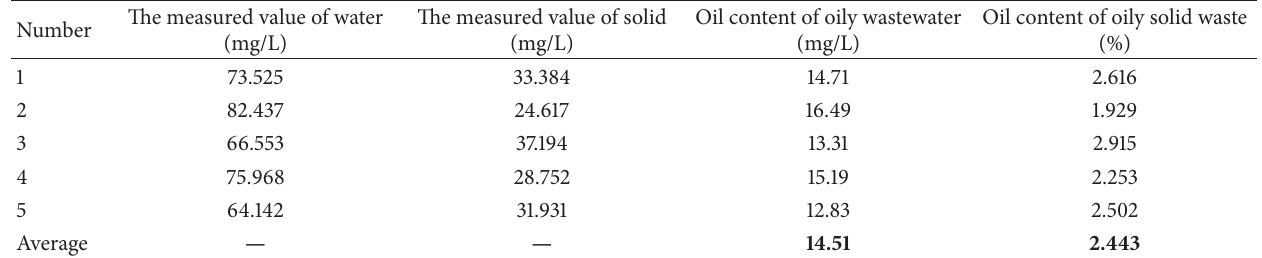
Table 6: The oil content of oily wastewater and oily solid